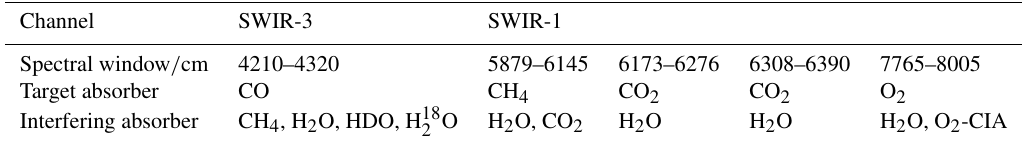
Table 1. Spectral windows with target and interfering absorbers. CIA refers to collision-induced absorption.